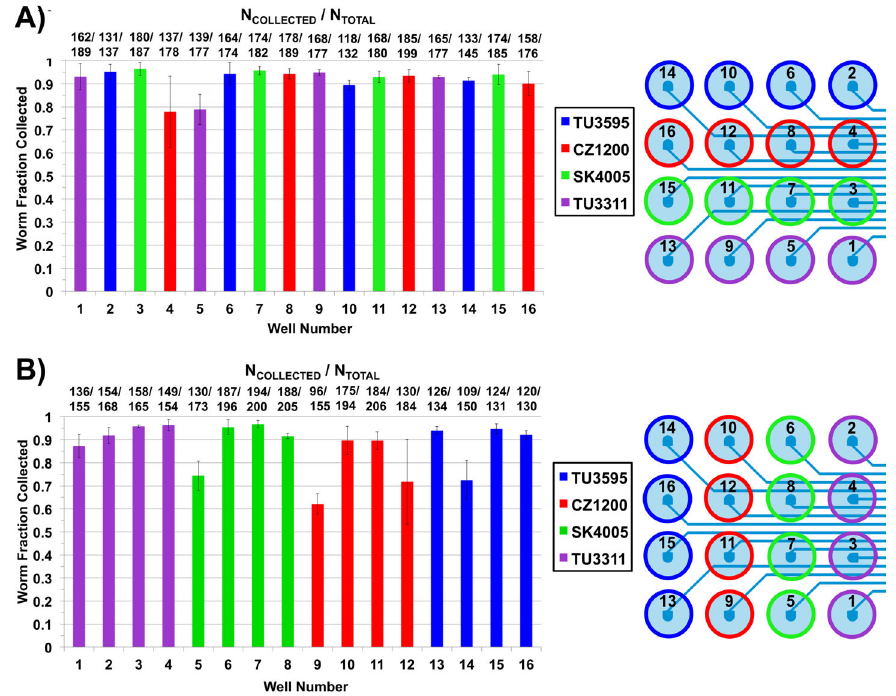
Figure 4. Population mixing eliminated during automated delivery at 20 psi (~138 kPa). The graphs show the fraction of animals collected after delivery from a given well that are of the same strain initially loaded into the well. The actual average number of collected worms over the average number of those initially loaded is indicated above each bar. A) Four distinct strains loaded in each row . B) Four distinct strains loaded in each column . A corresponding color-coded schematic on the right of both graphs indicates into which wells the strains were loaded at the beginning of both experiments. Each color represents a single type of